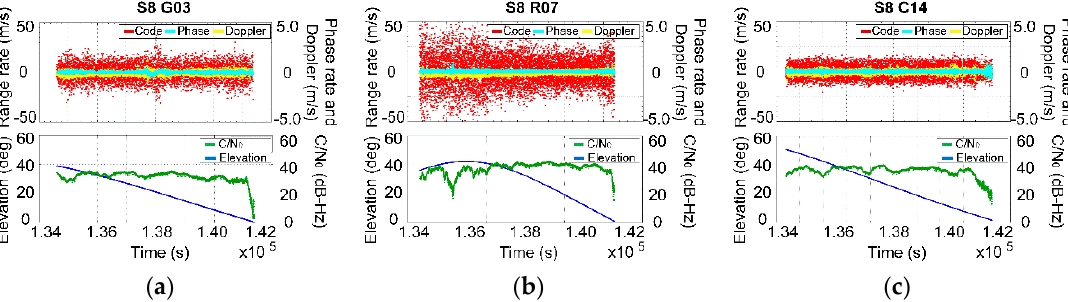
Figure 9. Comparison of the pseudorange rate, phase rate, and Doppler data from smartphones. ( a ) The number 3 satellite of GPS (G03); ( b ) the number 7 satellite of GLONASS (R07); ( c ) the number 14 satellite of BDS (C14).